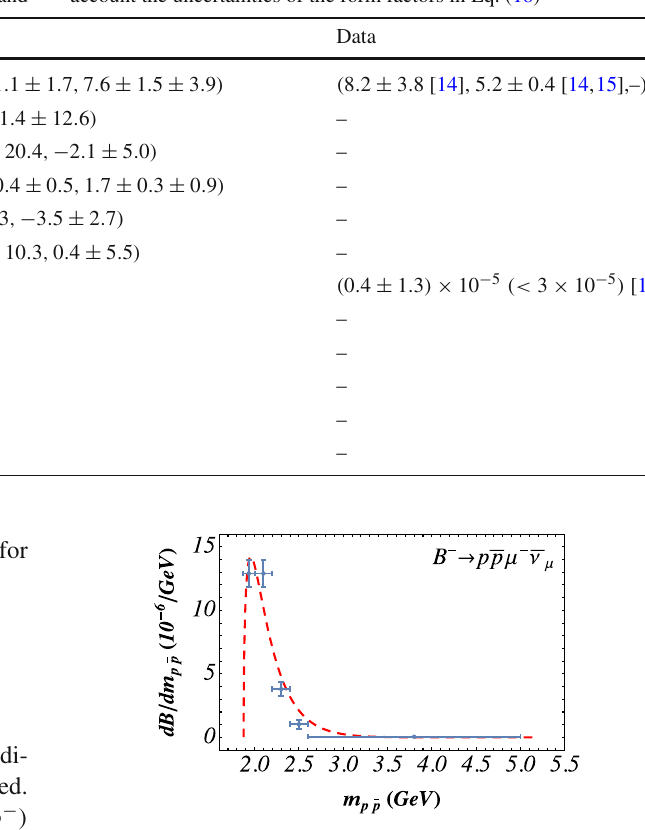
Fig. 4 The p ¯ p invariant mass spectrum of B − → p ¯ p μ − ¯ ν μ , where the data points are from LHCb